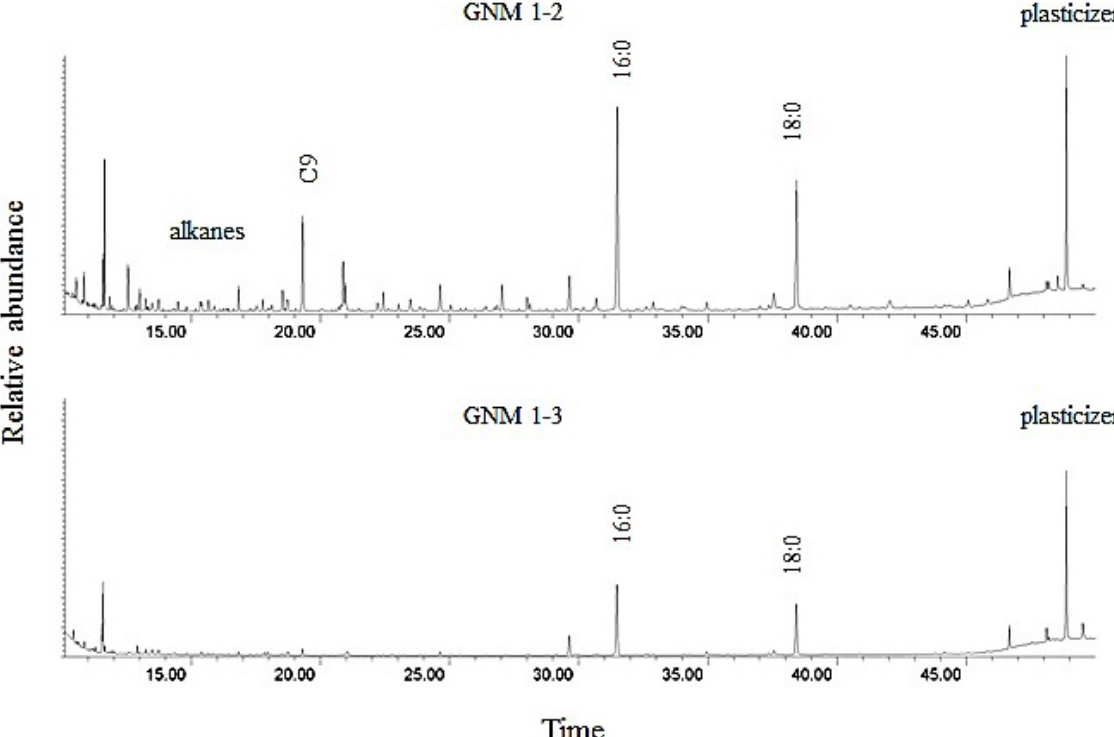
Figure 8. Partial total ion chromatograms for the cupule core (upper TIC) and control sample (lower TIC) from RMP-5. Peaks in the upper and lower TICs are plotted to the same